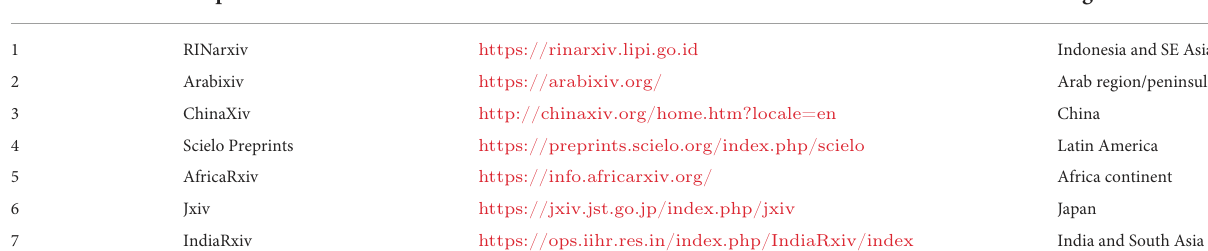
TABLE 1 Regional scope preprint servers.